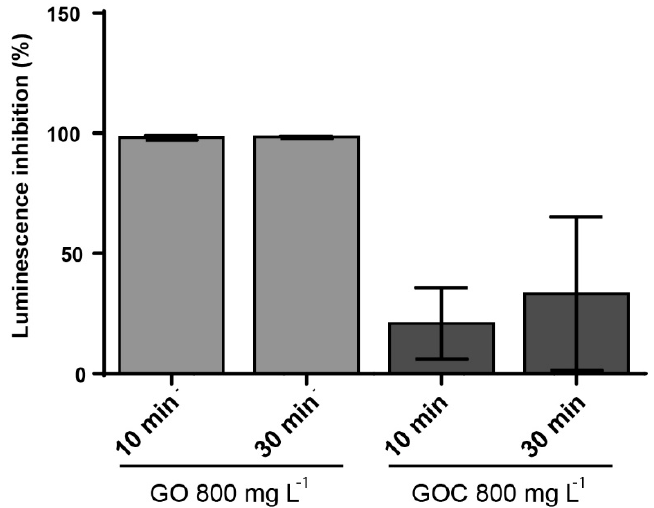
Figure 9. Luminescence inhibition assay of V. fischeri cells exposed to 800 mg L − 1 of GO and GOC during 30 min. The reported values are the averages of four biological replicates per culture condition.